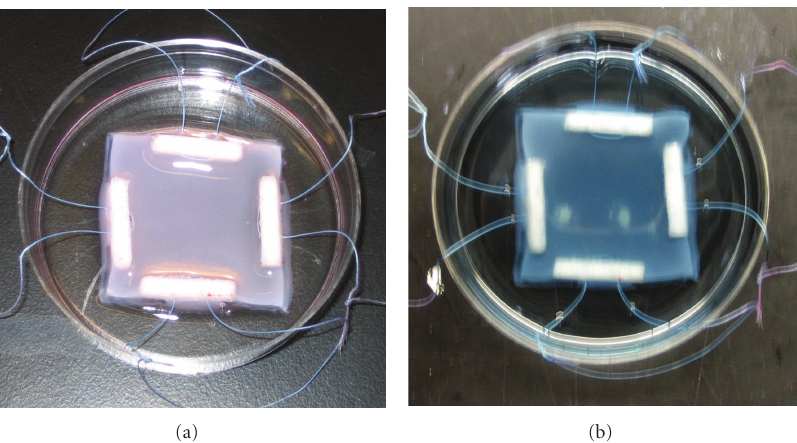
Figure 1: Collagen sca ff olds crosslinked with (a) 0.03% and (b) 0.1% GP for 6 hours. Four prethreaded polyethylene bars were polymerized into the collagen sca ff olds sample for biaxial tensile